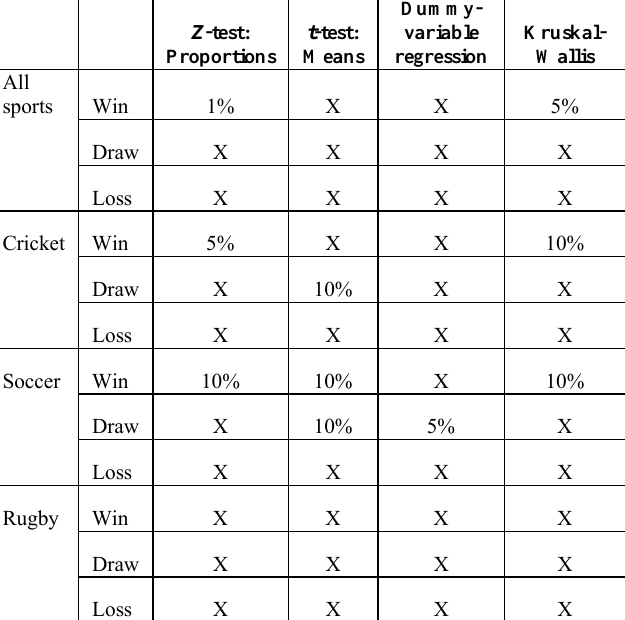
Table 6: Summary of statistical test